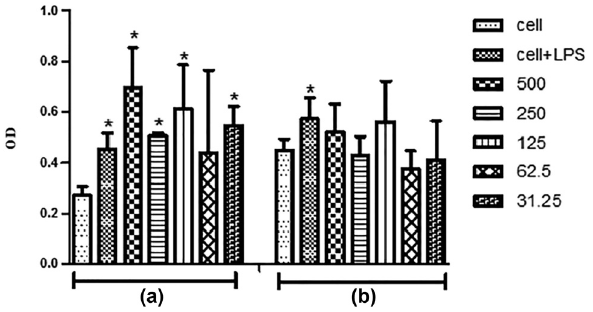
Figure 5: E ff ect of RPS on phagocytosis of the macrophages ( n = 3; *, p < 0.05 ) . ( a ) Stimulation with RPS alone, ( b ) co - stimulation with RPS and